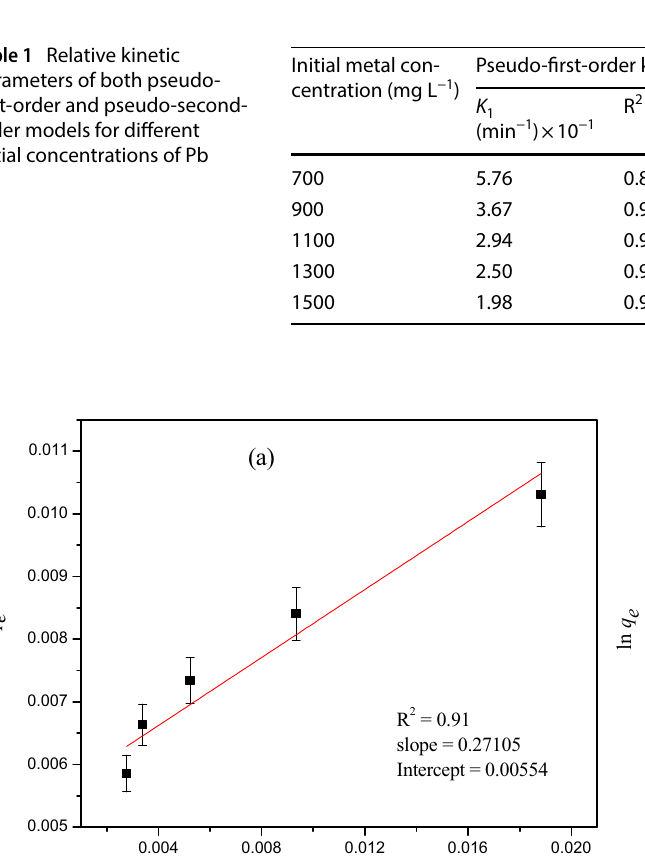
by Langmuir ( a ) and Freundlich ( b ), 3